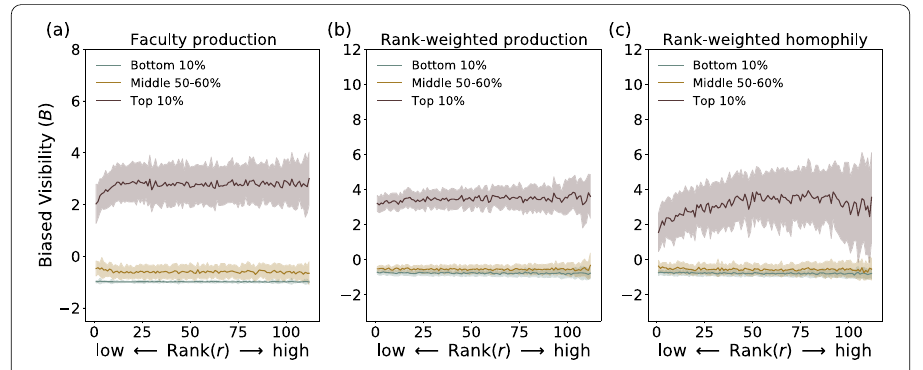
Figure S7 Biased visibility B for three groups of institutions (top 10%, middle 50–60%, and bottom 10%) as a function of perceiver institution’s rank r for three models for Business network ( a ) Faculty production model, ( b ) Rank-weighted production model, and ( c ) Rank-weighted homophily. All models started from the egalitarian initialization. Solid lines in ( a ), ( b ), ( c ) denote the average over 50 networks ensembles, and the shaded region indicates the standard deviation